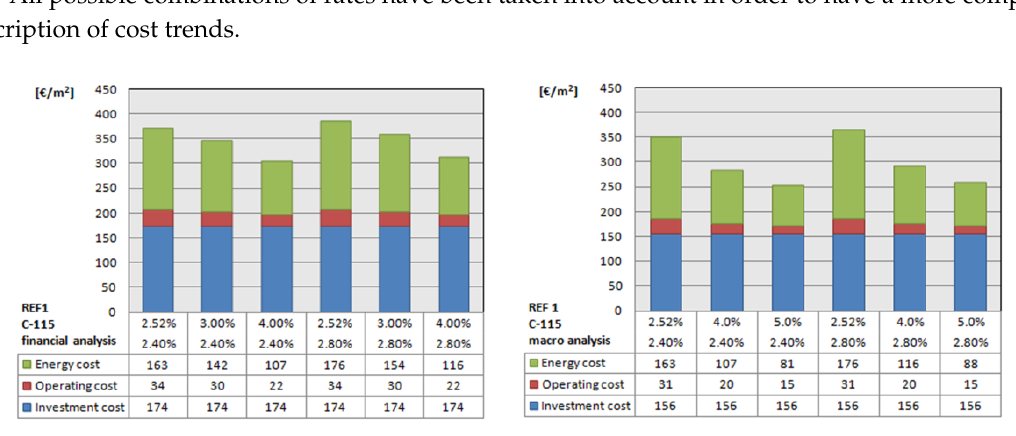
Figure 6. Financial and macroeconomic sensitivity analysis of the best combination for REF1.